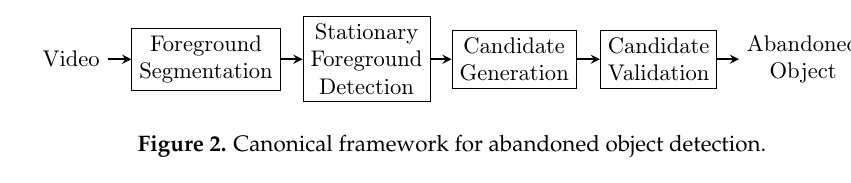
Figure 1. Example of abandoned luggage for the AVSS_AB_2007 sequence (http://www.eecs.qmul. ac.uk/~andrea/avss2007_d.html). Subfigure ( a ) shows an abandoned object when it is attended. An object (black box) is considered attended if a person (blue box) lies within a distance of twice the object’s width radius. In subfigure ( b ) the object is unattended since the person moves away farther than the defined distance.